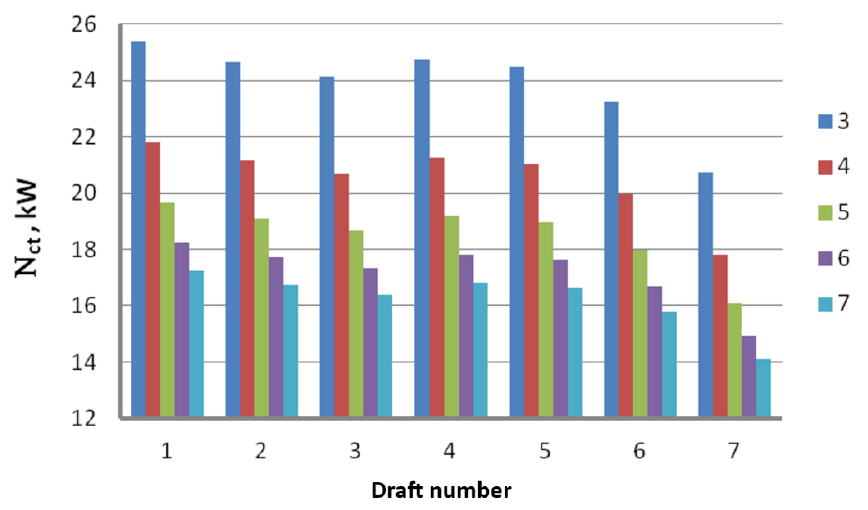
Figure 3. Influence of the drawing angle on the theoretical wire drawing power in respective drafts; v = 10 m/s.